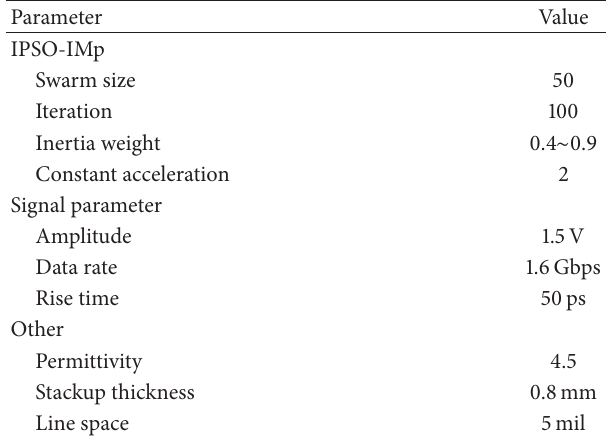
Table 2: Design and simulation of